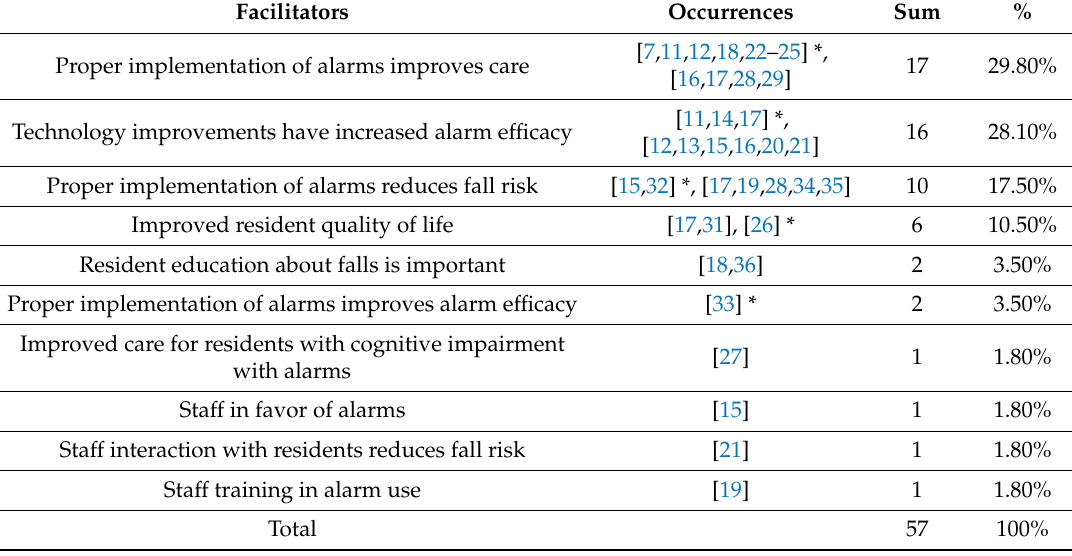
Table 1. Themes associated with alarms and fall